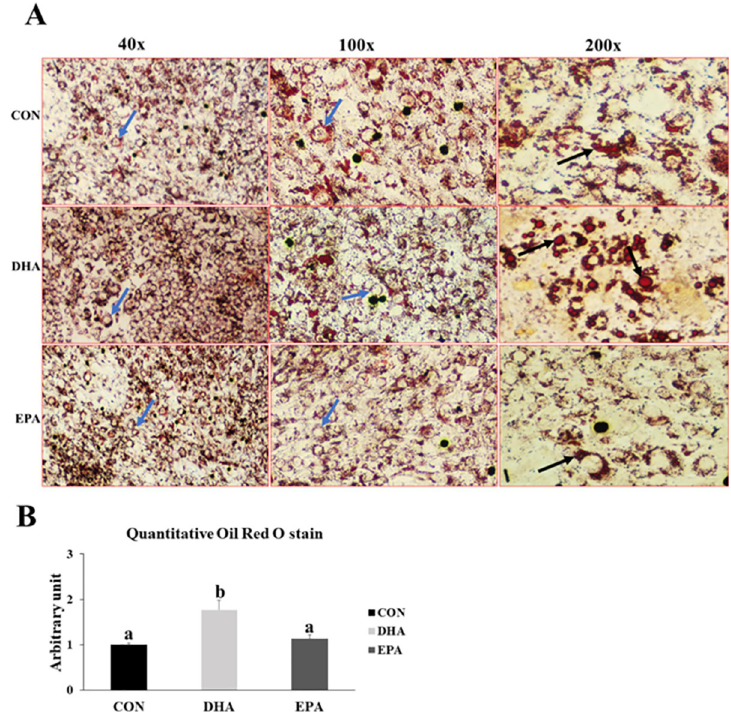
Fig 5. The effect of DHA and EPA on lipid droplets formation in C2C12 cells undergoing differentiation into white adipogenesis. The cells were treated with white adipogenesis induction differentiation medium (WIDM) in the absence (CON) or presence of individual doses of 50 μ M EPA and 50 μ M DHA for 10 days. A) Microscopic view of trans-differentiated cells stained with ORO from different groups. B) Quantitative measurement of ORO stain from the different groups. Data is represented as mean ± SEM, b means P < 0.05, ANOVA; n = 4. Black arrows refer to lipid droplets while blue arrows represent rounded cells.